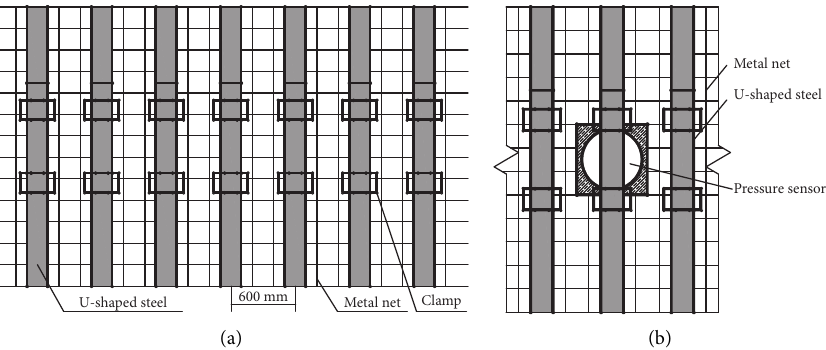
Figure 11: Design of gangue retaining support. (a) Support design with U-shaped steel. (b) Pressure monitoring of gangue retaining support.